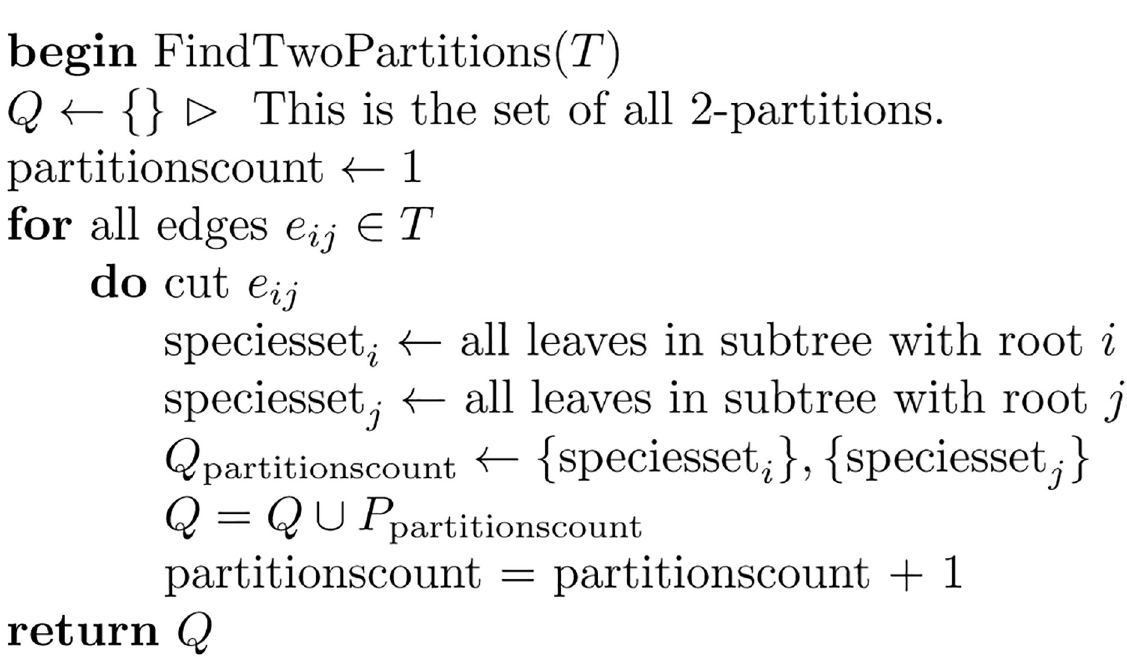
PLOS ONE | https://doi.org/10.1371/journal.pone.0281824 March 24,